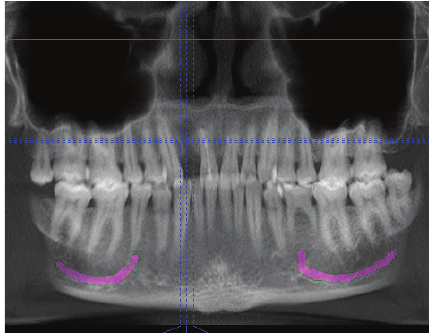
Figure 4: Preoperative CBCT with reformatted panoramic view. Gross radiolucency may be noted at the edentulous